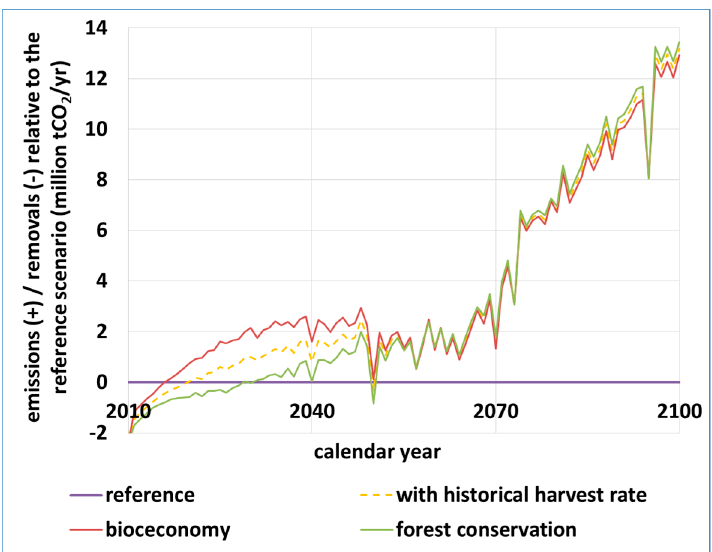
Figure 12. Balance of CO 2 emissions from declining beech forests (in million t CO 2 ) relative to the reference of stable climate, in three harvest rate scenarios (see Appendix A.6), assuming a 2.5 °C temperature increase by 2100 and that only a fraction of the diseased trees can be salvaged (Somogyi, original).